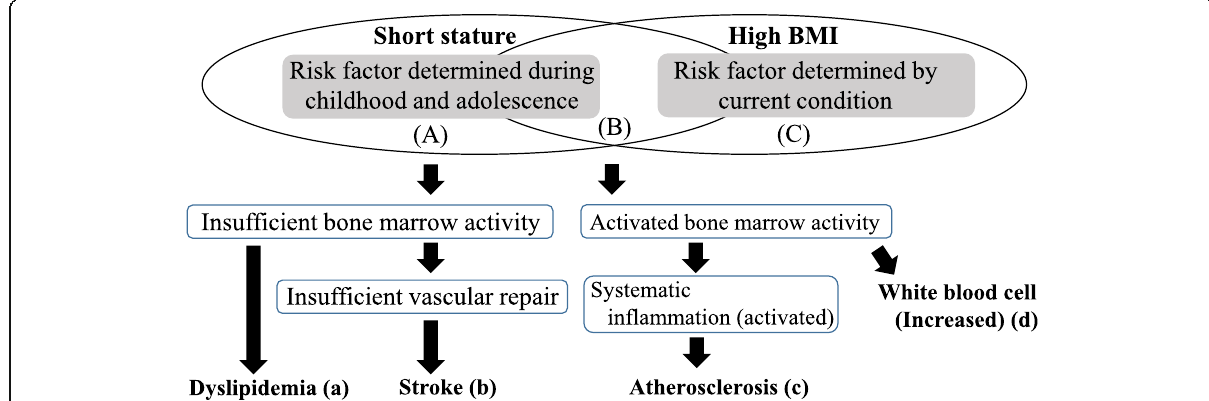
Fig. 4 Association between short stature and high BMI on bone marrow activity [74]. ( A ) Short stature without a high BMI. ( B ) Short stature with a high BMI. ( C ) High BMI without short stature. A higher risk of stroke was observed among ( A ) [7], while a higher prevalence of atherosclerosis was observed among ( B )